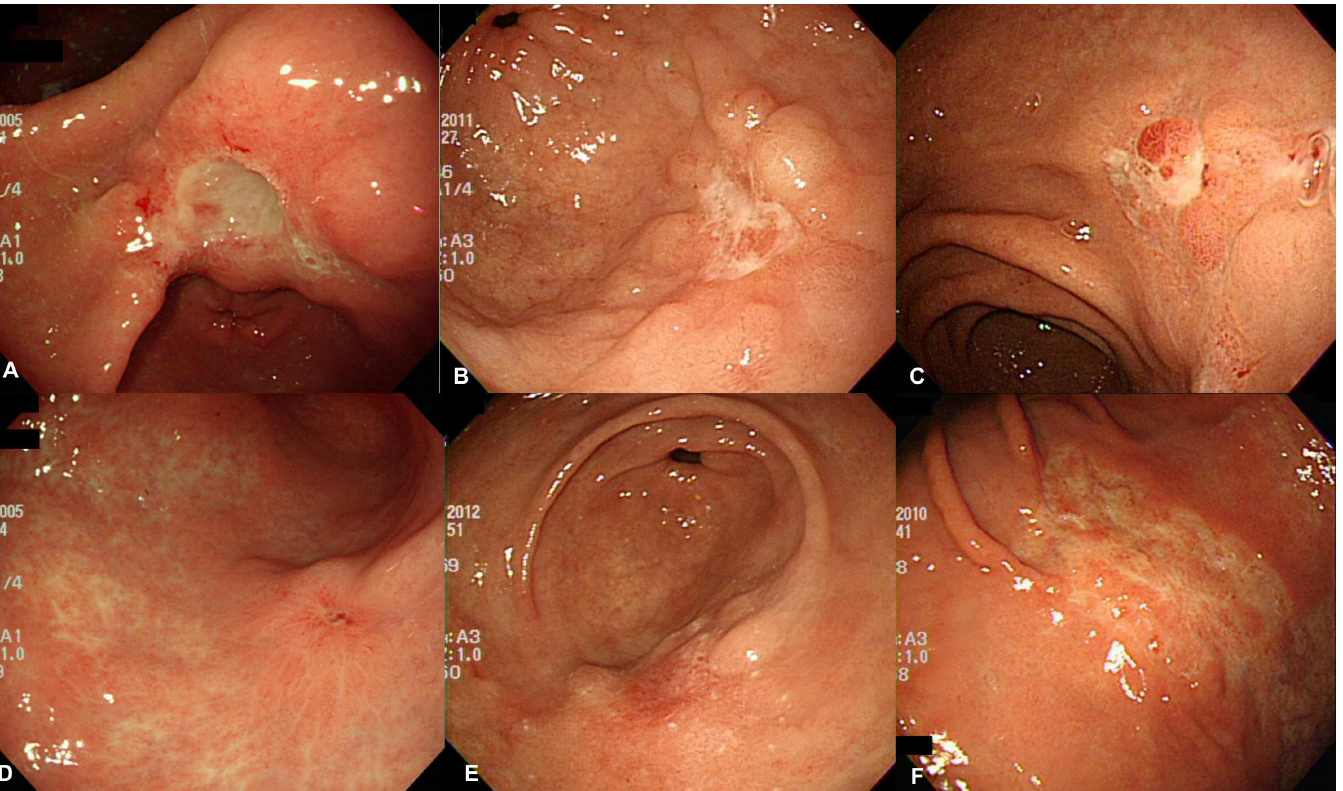
Fig 1. Endoscopic appearance of stages of ulcer in EGC. (A) A1 stage (B) A2 stage (C) H1 stage (D) H2 stage (E) S1 stage (F) S2